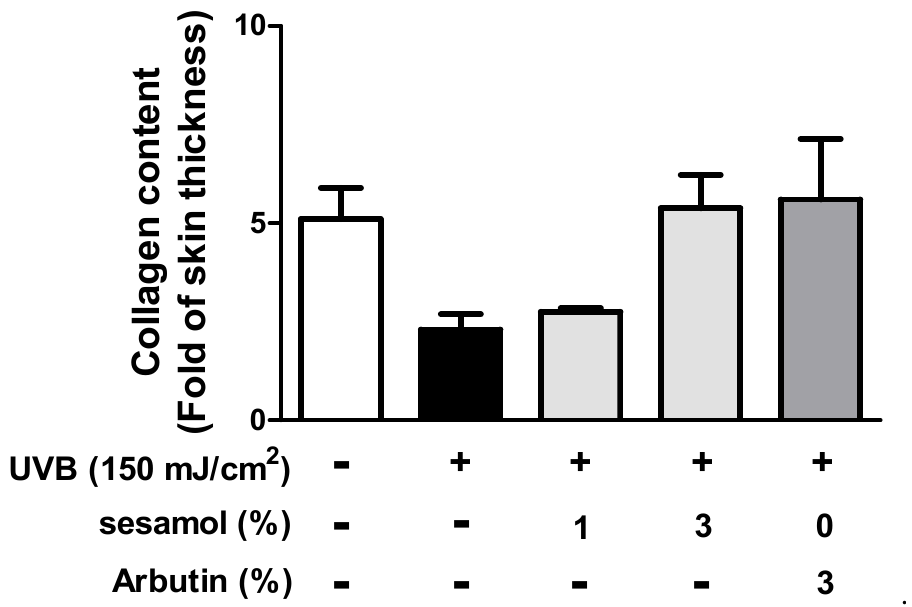
Figure 8. Light micrographs of histological sections stained with Masson’s trichrome in UVB-irradiated C57BL/6 mice that received topical application of sesamol once a day to the ear skin. The collagen content decreased in the UVB-irradiated group, whereas topical application of sesamol once a day to the ear skin restored the collagen level.